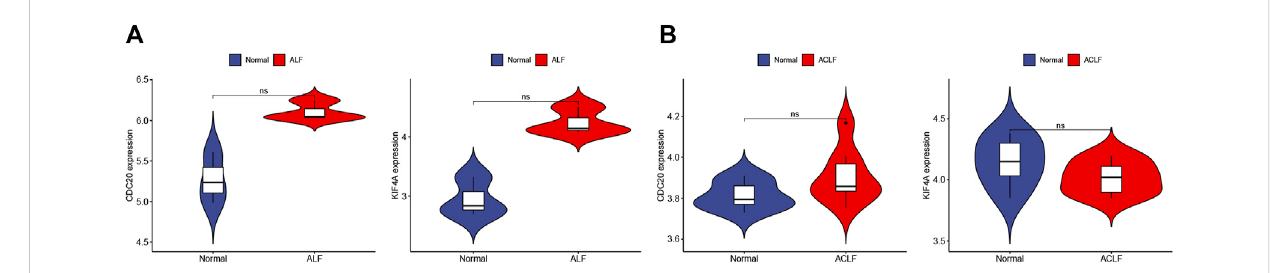
FIGURE 4 Validation of hub genes in ALF and ACLF by Violin plots. (A) The expression of representative hub genes between livers of ALF patients with normal livers was compared. (B) The expression of representative hub genes in ACLF and normal livers was compared. Eight ACLF and six control healthy livers were obtained from GSE139602. Data were statistically analyzed using the Wilcoxon test (ns indicates no signi fi cant difference).